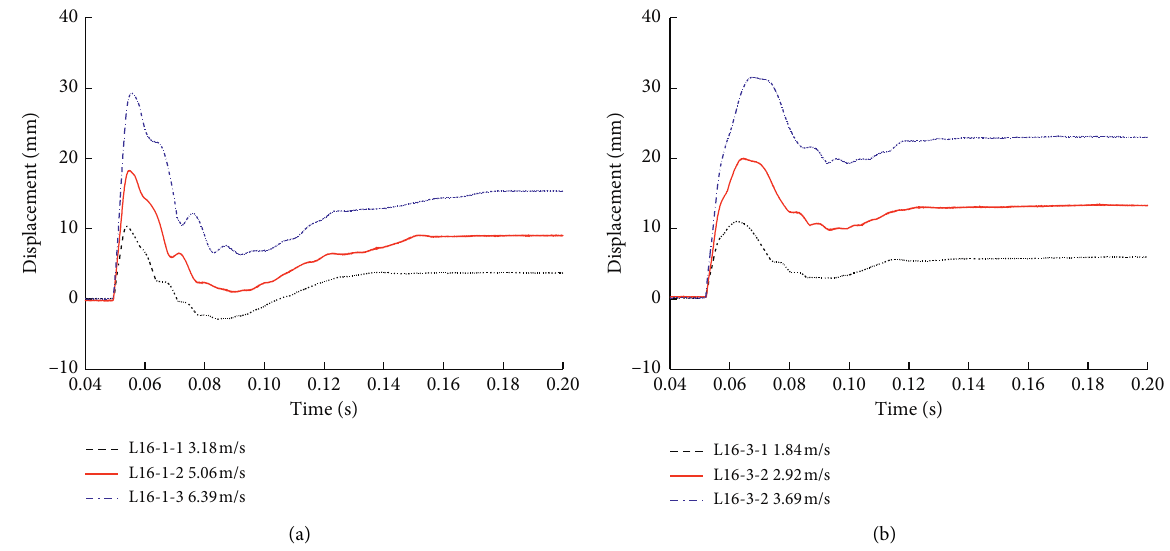
Figure 7: Time-history curves for the displacements after cumulative impacts: (a) L16-1; (b) L16-3.